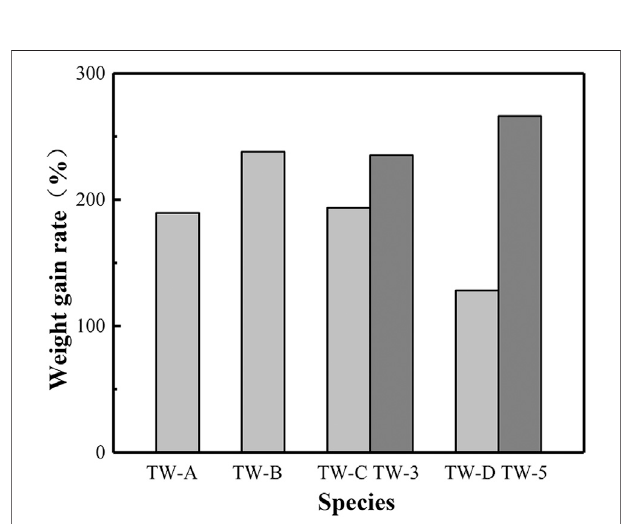
FIGURE 7 | ATR-FTIR of the samples before and after treatment ( B is the enlarged picture in the dotted box of A ).